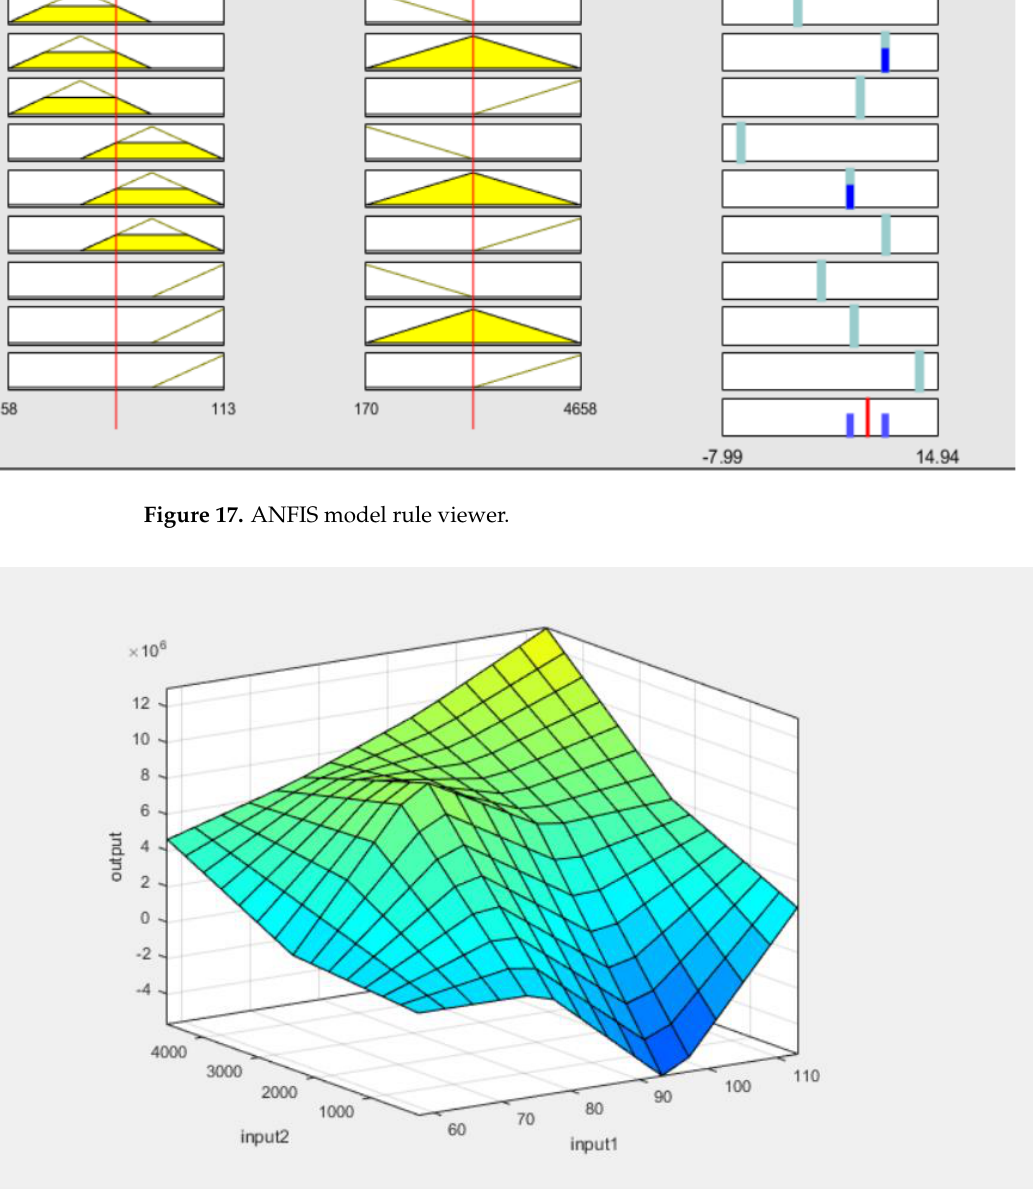
Figure 18. 3D image of the ANFIS model. (Input 1= time, input 2 = speed of vehicles, output = traffic volume).